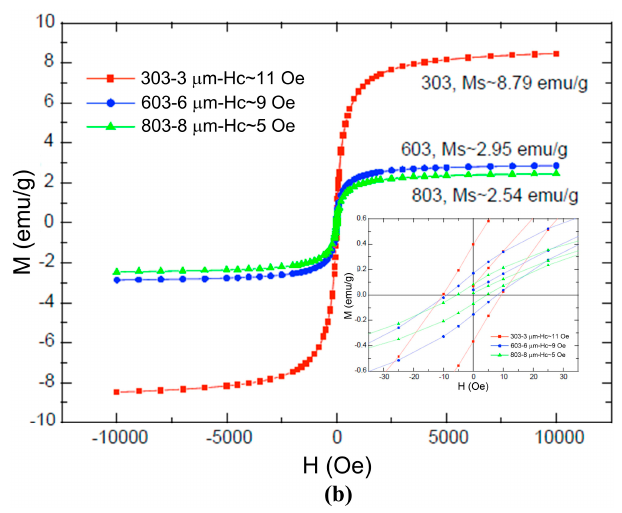
Figure A1. Magnetization curves for ( a ) M-270 streptavidin beads and ( b ) COMPEL™ beads. (Reprinted with permission from refs. [56]—Copyright 2005 Elsevier, and [57]—Copyright Bangs Laboratories, Inc.™).